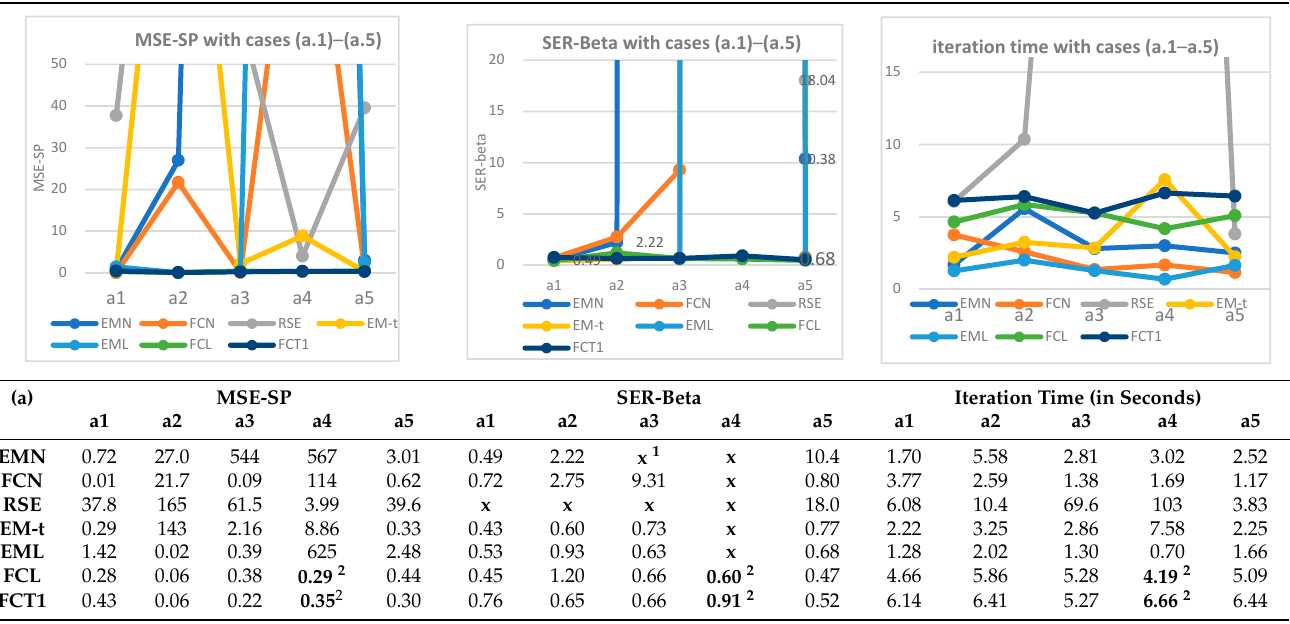
Table 1. MSE of the switch-point and regression parameter estimates for Model (a) under scenarios (a1)–(a5).